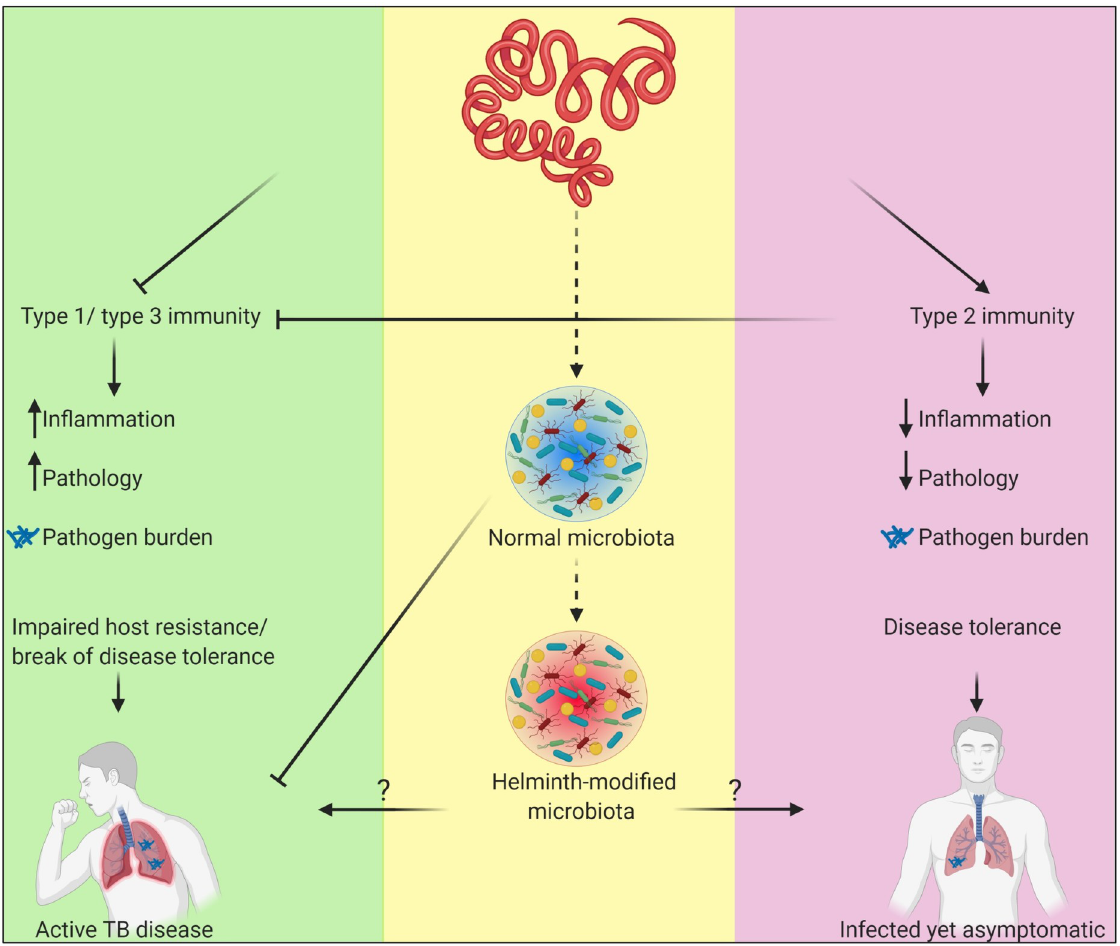
Fig 1. Helminth infections, eliciting robust type 2 immune responses, might contribute to Mtb disease tolerance by inhibiting type 1 and type 3 immune responses, thus reducing inflammation and pathology while maintaining bacterial burden. An alternative, but not mutually exclusive, possibility is that helminth-mediated changes to the gut microbiota shape TB outcomes. The robust regulatory capacity of the gut microbiota (via immune suppression, metabolite processing, and niche competition) is an appealing mechanism to explain the contradicting data regarding the exact role of helminth infections in TB disease progression and disease tolerance in asymptomatic infected patients. This figure was created with BioRender.com. M AU : AnabbreviationlisthasbeencompiledforthoseusedthroughoutFig 1 : Pleaseverifythatallentriesarecorrect : tb , Mycobacterium tuberculosis ; TB, tuberculosis.